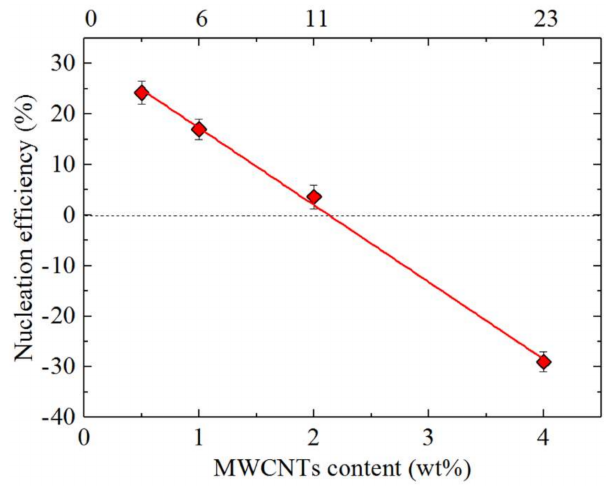
Figure 10. Nucleation efficiency as a function of MWCNTs content. The PC content is indicated in the top